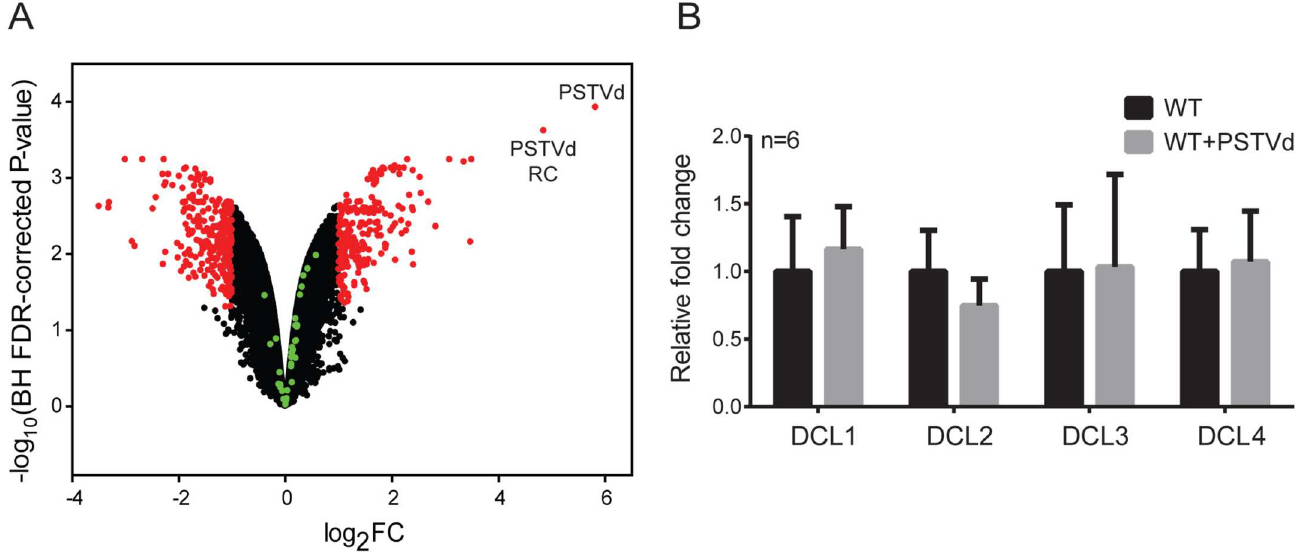
Fig 4. DCL levels upon PSTVd infection. (A) Volcano plot from microarray experimentwith RNA from leaves of WT and PSTVd N . benthamiana infected plants (3wpi). N . benthamiana genes with no significant alteration of their expression level are indicatedwith black dots, while red dots represent genes with a significant higher or lower expression (fold change (FC) (cid:21) 2, Benjamini-Hochberg(BH) FDR-corrected P-value < 0.05) in PSTVd infected plants compared to WT plants. The 35 N . benthamiana RNAi components (describedin [10]) are indicatedwith green dots. The PSTVd virus sequence and its reverse complement (RC) are both labeled(see micorarray design) (B) qPCR experiments of DCL transcripts upon infection. Two reference genes (L23, FBOX) were used for normalization. No significant differences were observed.